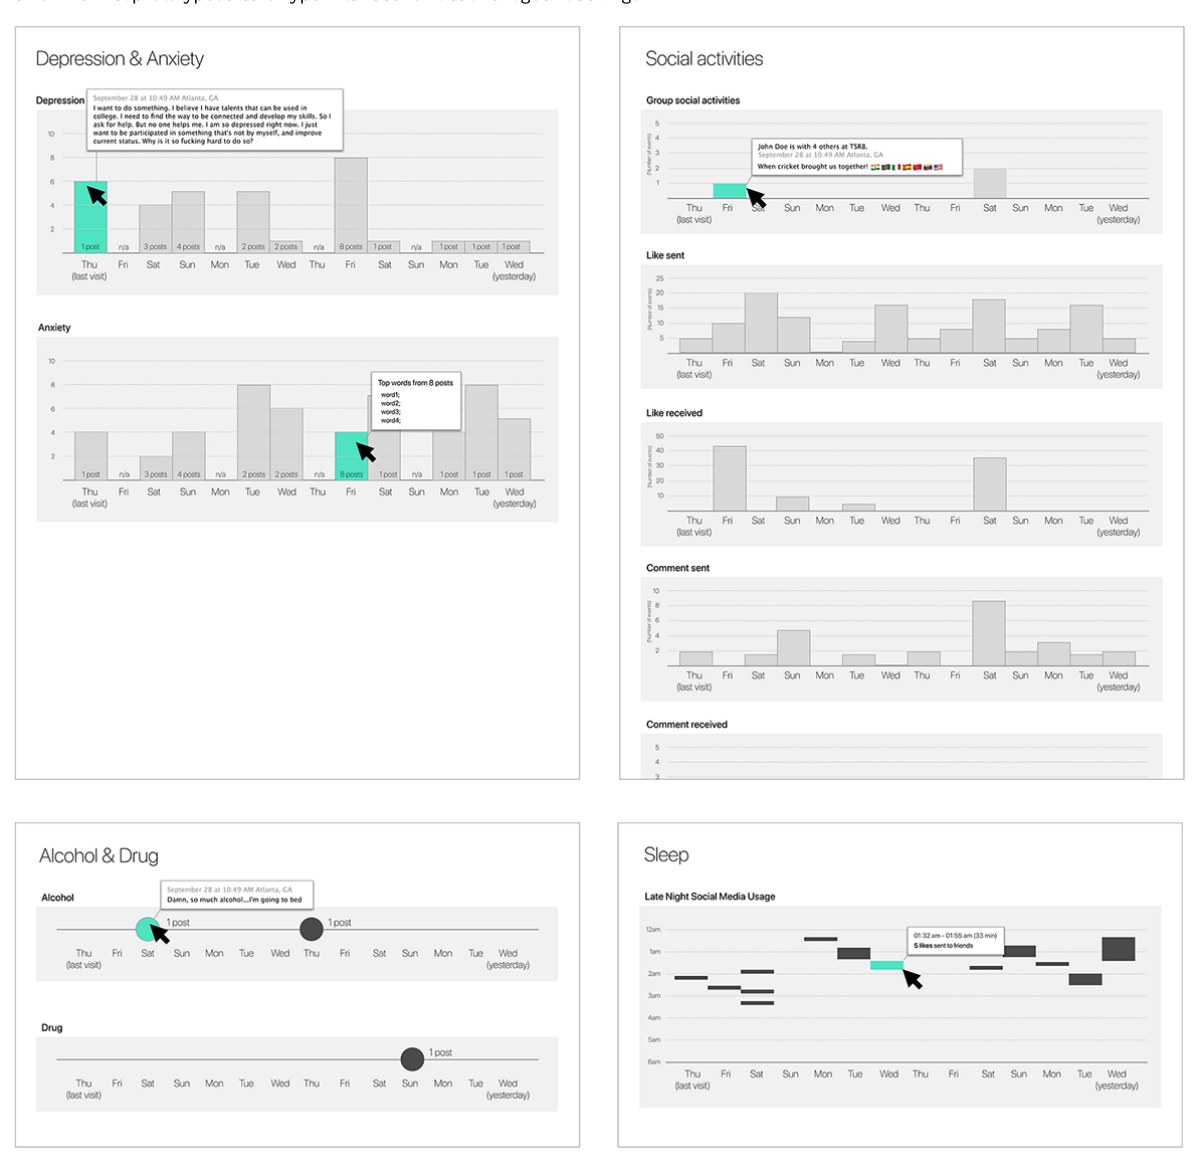
Figure 1. The first prototype: a card-type interface for treatment goal